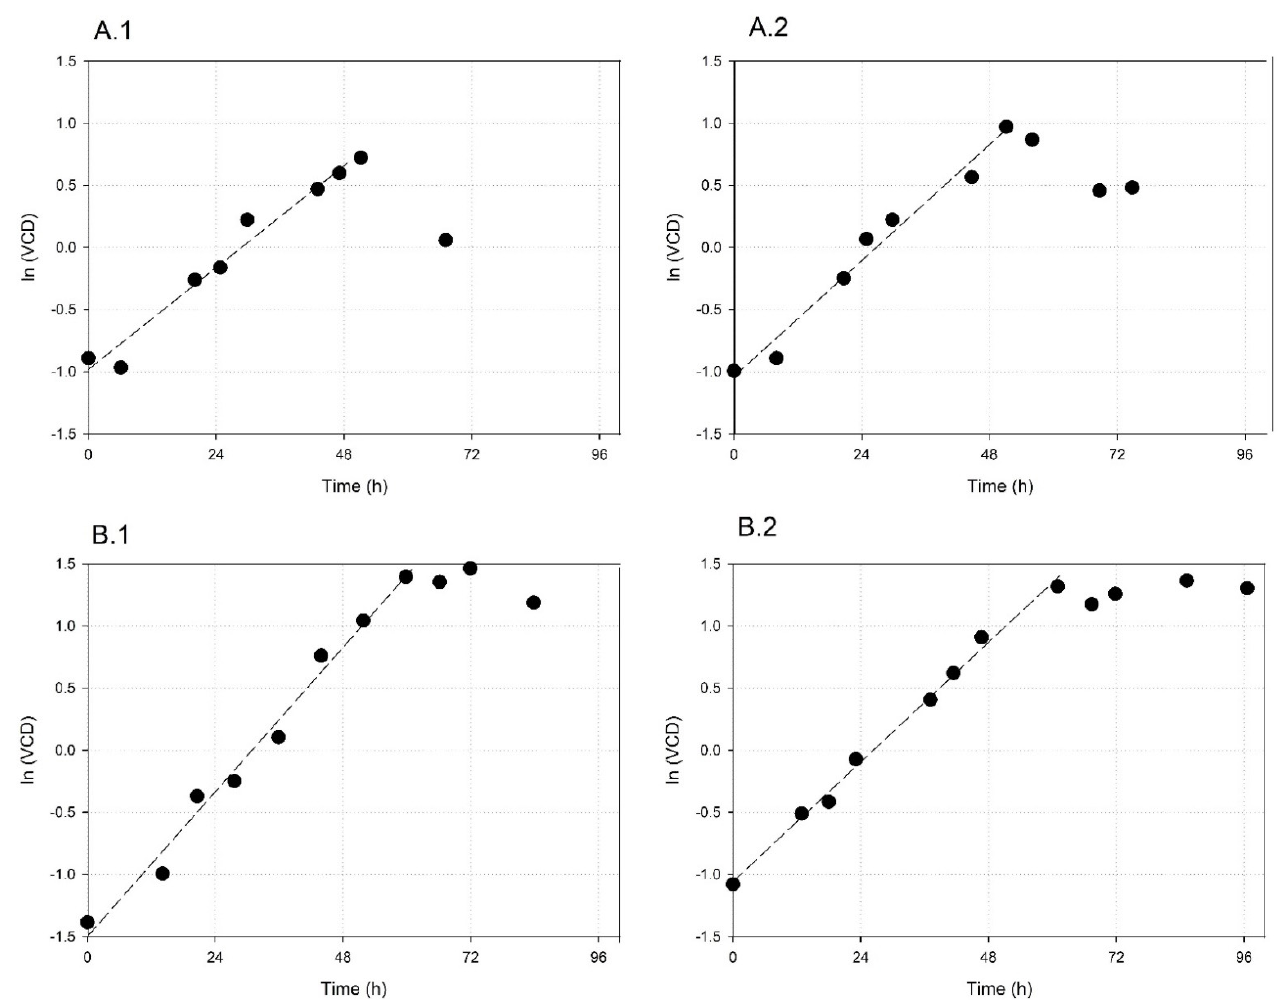
Figure 3. Two L bioreactor batch cultures of the parental KB26.5 cell line ( A.1 and A.2 ) and the engineered KB26.5-BHRF1 ( B.1 and B.2 ). Napierian logarithm of viable cell density versus time ( ● ). Duplicate cultures are presented for each cell line. Table 1. Specific consumption rates of glucose, amino acids and oxygen, and production rates of lactate and ammonia for KB26.5 and KB26.5-BHRF1 cell lines. Cultures were run in 2 L bioreactors. The specific rates are part of the 38 external measured fluxes used as modeling constraints, and are expressed in nmol/(mg · h)